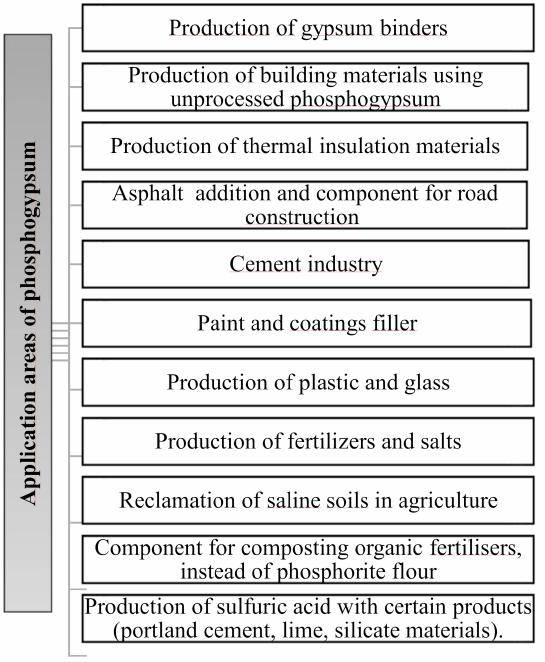
Figure 3. The main directions of phosphogypsum